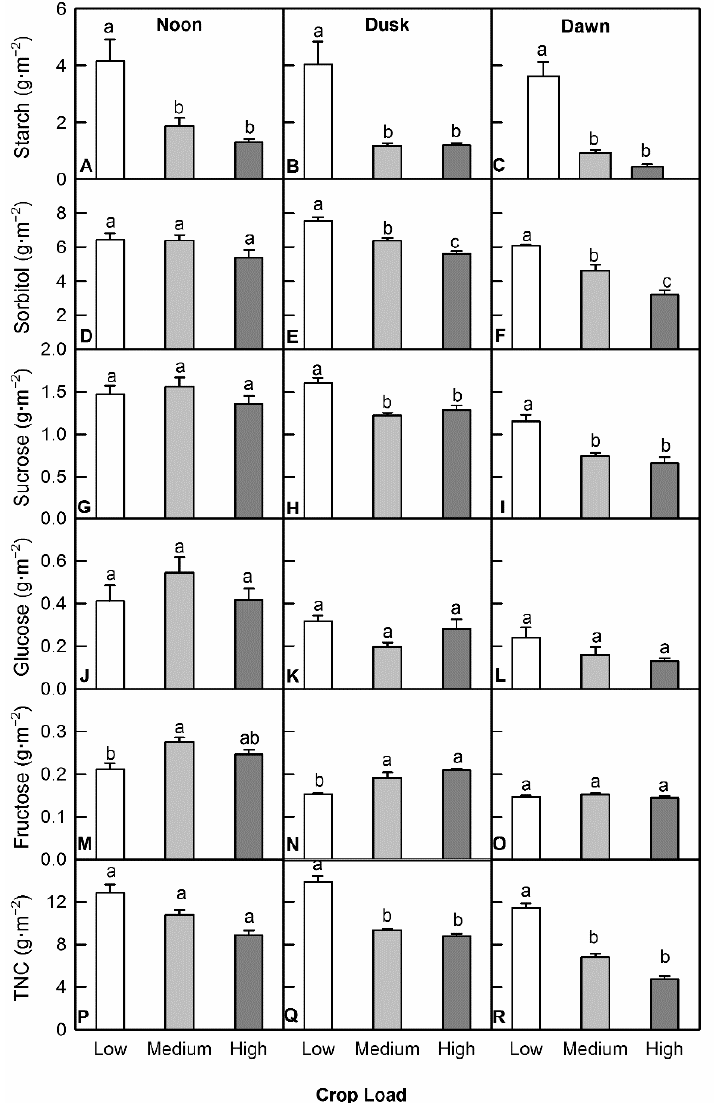
Figure 3. Effects of crop load on the concentrations of non-structural carbohydrates at noon, dusk, and dawn in apple leaves: starch ( A – C ), sorbitol ( D – F ), sucrose ( G – I ), glucose ( J – L ), fructose ( M – O ), and total non-structural carbohydrates ( P – R ). Each bar is mean ± SE ( n = 6). Different letters above the bars indicate a significant difference for Tukey’s HSD test at p < 0.05.